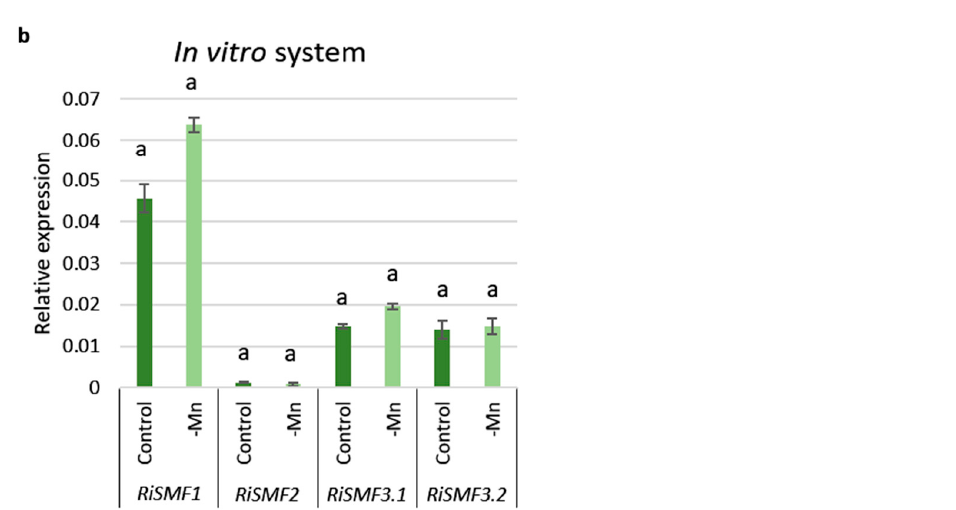
Figure 6. Effect of Mn deficiency on RiSMF s expression. ( a ) Gene expression was analysed in RNAs isolated from mycorrhizal roots (IRM) and ERM collected from chicory plants, developed in the whole-plant bidimensional culture system (in vivo system) and watered with half-strength Hoagland solution (control, 4.5 µM) or a modified nutrient solution without Mn (-Mn). ( b ) Gene expression was analysed in RNAs isolated from ERM developed in monoxenic cultures (in vitro system) in liquid M media without Mn (-Mn) or containing 2 µM Mn (control). Relative-gene-expression levels were calculated, using the 2 −Δ CT method with RiEF1 α as internal control. Bars represent standard error. Different letter types indicate statistical data for each gene. Different letters indicate significant differences ( p < 0.05; n = 3) between treatments.